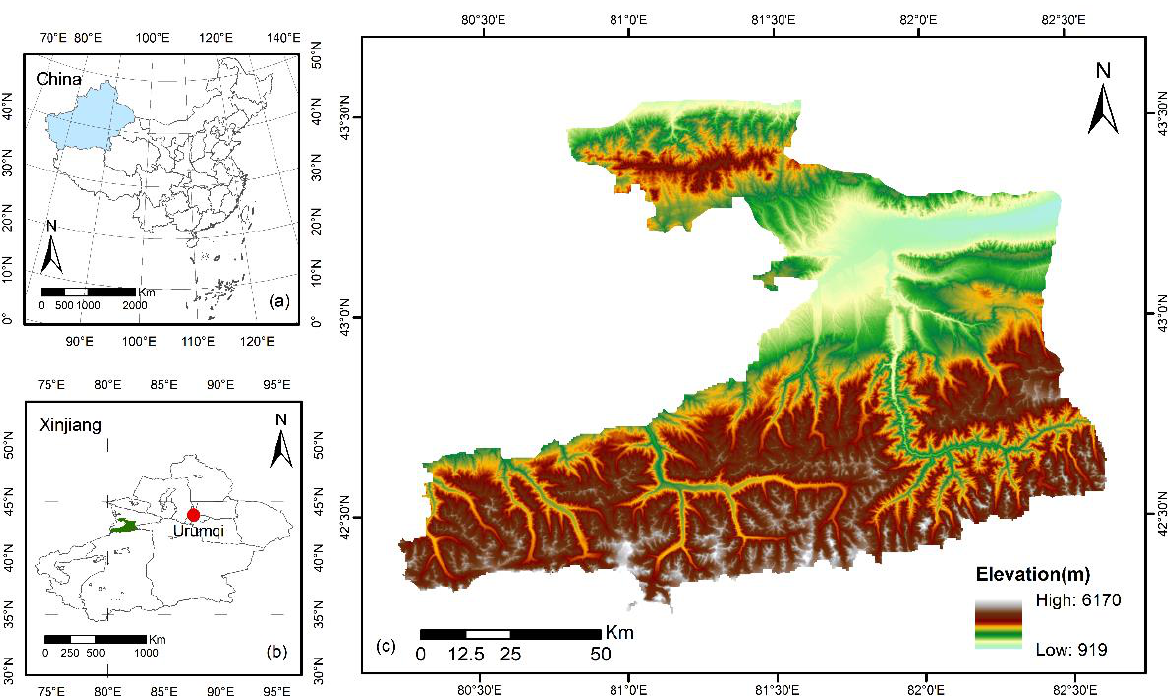
Figure 1. The location and topographic features of the study area, ( a ) in China, ( b ) in Xinjiang Uygur Autonomous Region and ( c ) are topographic features of the study area, and elevation data were obtained from ASTER Global Digital Model.